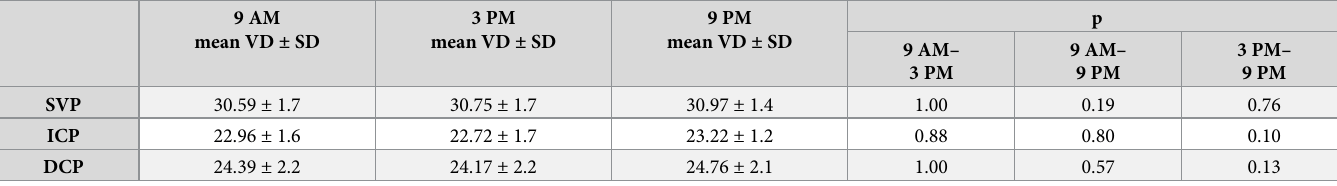
VD, vessel density; standard deviation, SD; SVP, superficial vascular plexus; ICP, intermediate capillary plexus; DCP, deep capillary plexus. P-values were generated from pairwise comparisons (9 AM to 3 PM, 9 AM to 9 PM and 3 PM to 9 PM). P-values of p < 0.05 were considered statistically